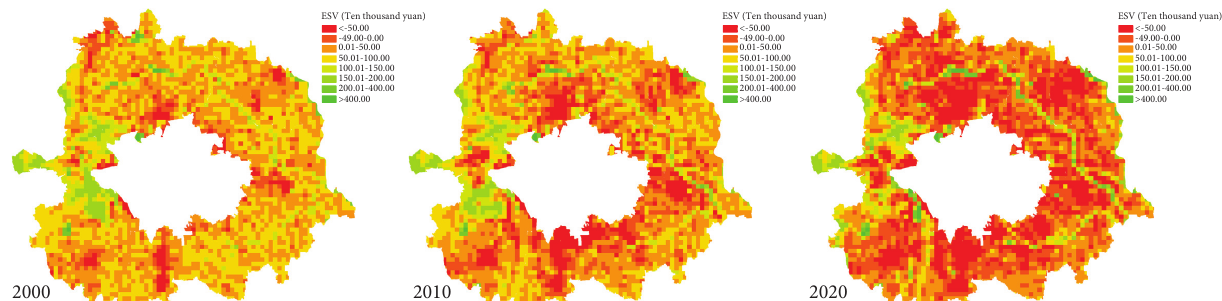
Figure 6: ESV change of the second green isolation area